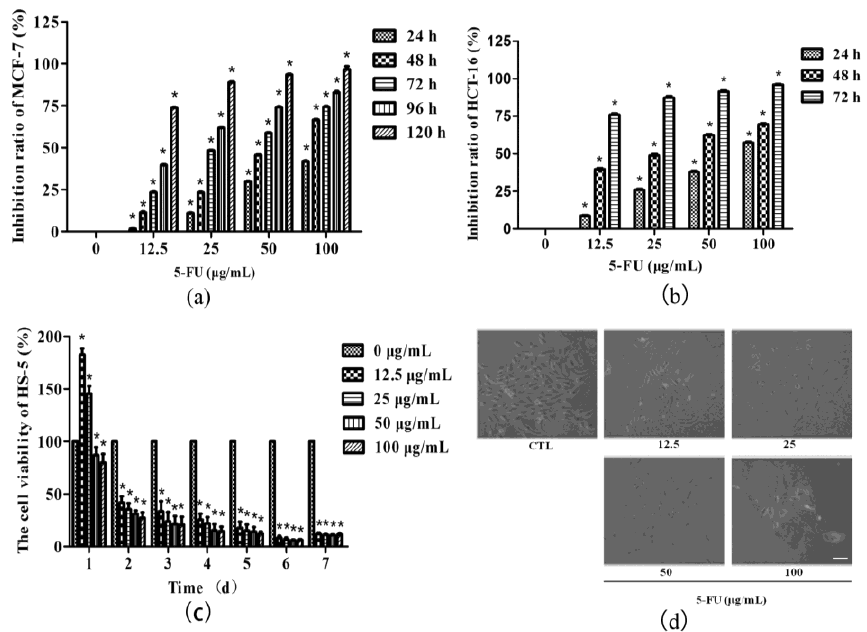
Figure 1. 5-fluorouracil (5-FU) inhibits the growth of both tumor cells and bone marrow stromal cells in a dose and time-dependent manner. Cell proliferation assay was performed via the Cell Counting Kit-8 kit. ( a ) Cell inhibition rates are presented as (OD control group − OD experimental group )/OD control group × 100%. MCF-7 treated without 5-FU was used as a control; ( b ) The inhibitory effects of 5-FU on HCT-16 cells are presented as inhibition rates: (OD control group − OD experimental group )/OD control group × 100%. HCT-16 treated without 5-FU was used as a control; ( c ) The cell viabilities of HS-5 were almost entirely decreased with tumor-suppressive doses of 5-FU. Viability rate = OD experimental group /OD control group ×100%. The cell viabilities of HS-5 without 5-FU treatment on each day were set as 100%. Results of HS-5 cell viability were normalized to the OD value of control HS-5; ( d ) Representative images of Fibroblast-colony forming unit (CFU-F) formed from 5-FU-treated and control HS-5 cells by phase contrast microscopy. CFU-F frequency decreased with increasing 5-FU doses (Scale bar = 50 μm). * p < 0.01 vs. control. CTL: Control; OD: optical